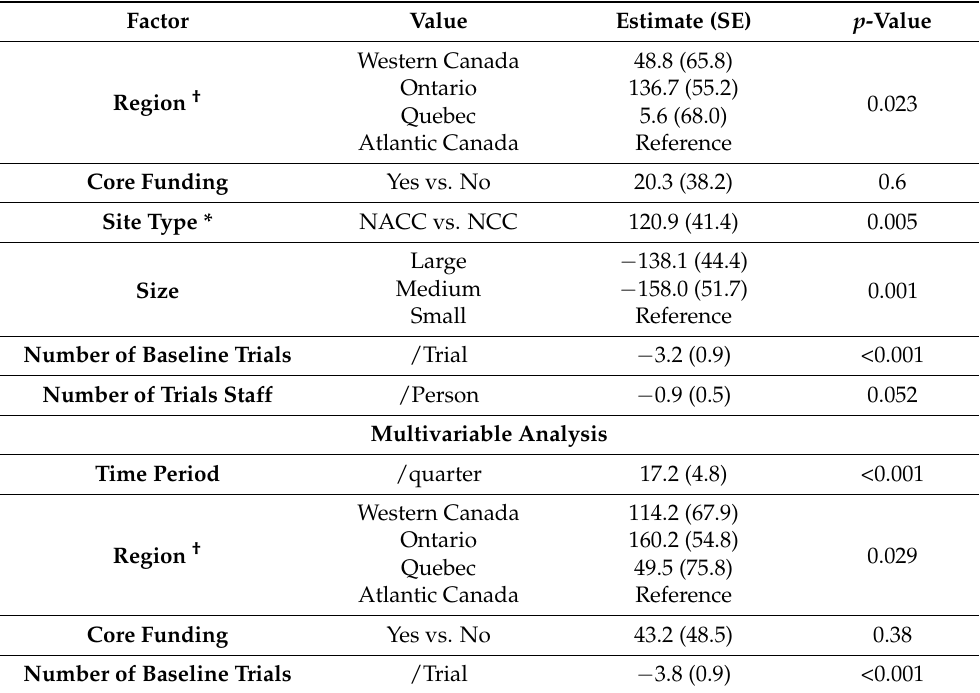
Table 4. Prognostic factors of change in accrual (repeated measures) % change. No interaction between region and time ( p = 0.80) in multivariable model.